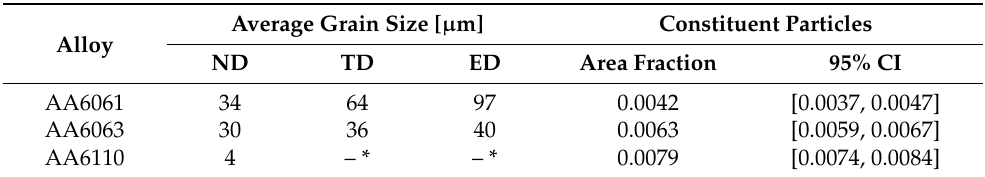
Table 2. Average grain size found from EBSD measurements and total area fraction of constituent particles along with the 95% confidence interval